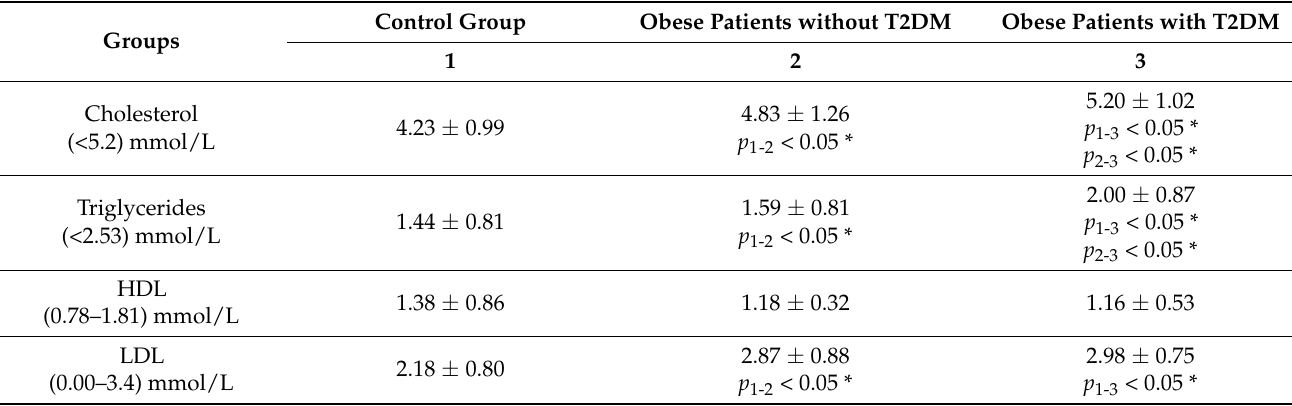
Table 1. Basic biochemical parameters of lipid metabolism in obese patients with and without type 2 diabetes mellitus (T2DM).